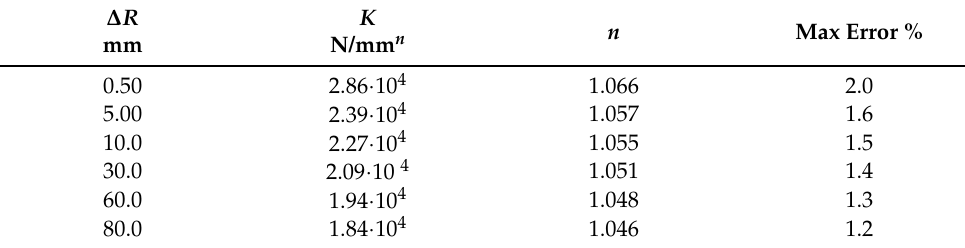
Table 6. Polynomial version of Goldsmith’s [23] contact force model (Steel).